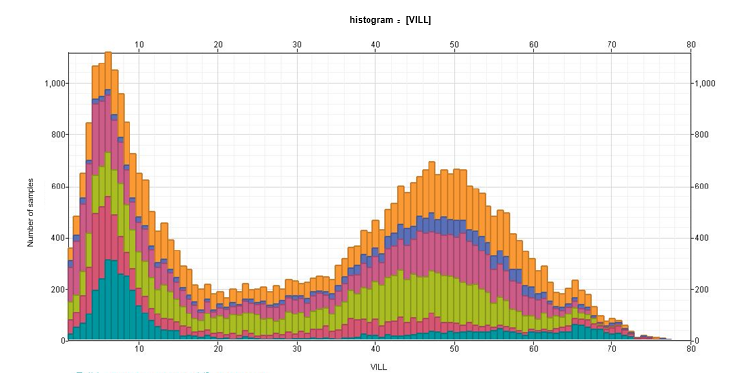
Fig. 10 Statistical chart of consistency of shale interpretation in the study area.